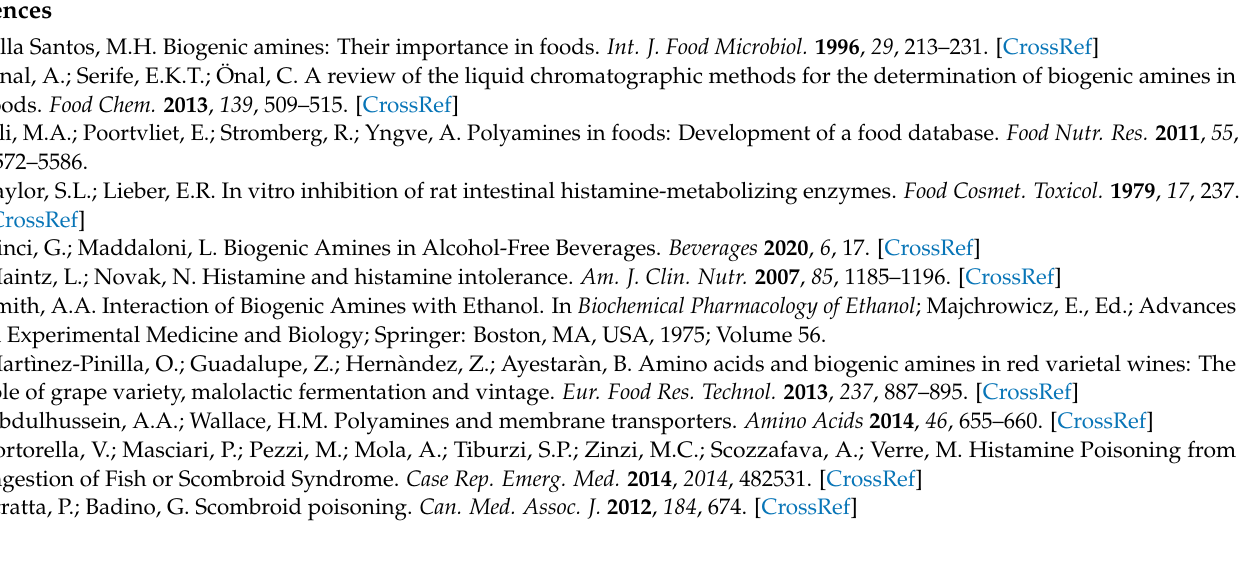
samples. Table S1: Performance characteristics of HPLC-UV/Vis method. Table S2: Performance characteristics of the LC-ESI-MS